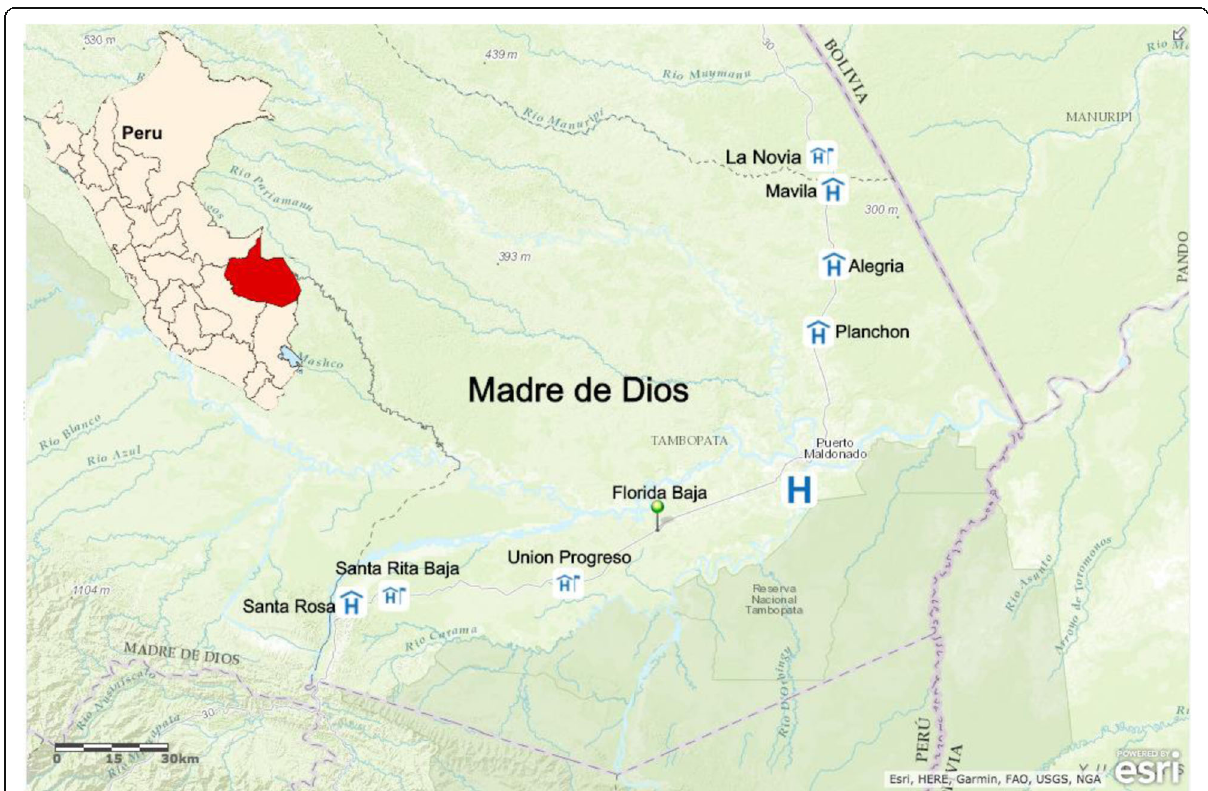
Fig. 2 Map of Madre de Dios and the surrounding eight communities involved in the study. Created Using: ArcGIS Online [Internet]. Redlands, CA: Environmental Systems Research Institute (ESRI); Available from: